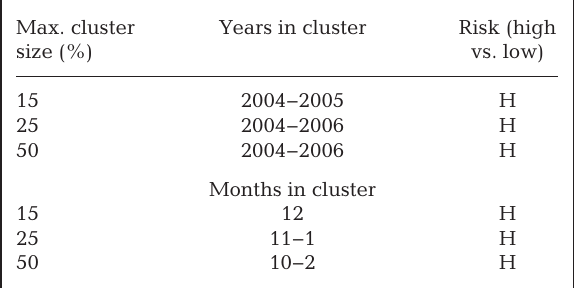
Table 3. Sensitivity analysis for the purely temporal SaT - Scan analysis to identify annual and seasonal variation in sea lice infestation of salmon Max. cluster